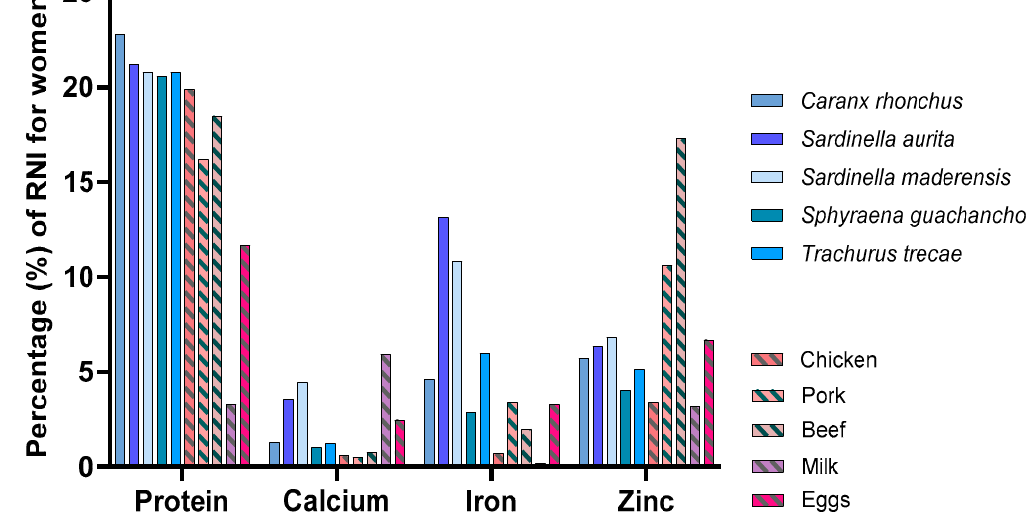
Figure 3. The contribution of protein, calcium, iron, and zinc (in percentage) to the recommended nutrient intakes (RNI) for women, from the consumption of a 50 g portion fillet of the sampled fish species and various terrestrial animal food products.